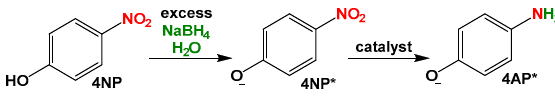
Figure 1. Catalytic reduction of 4-nitrophenol (4NP) to 4-aminophenolate (4AP*).